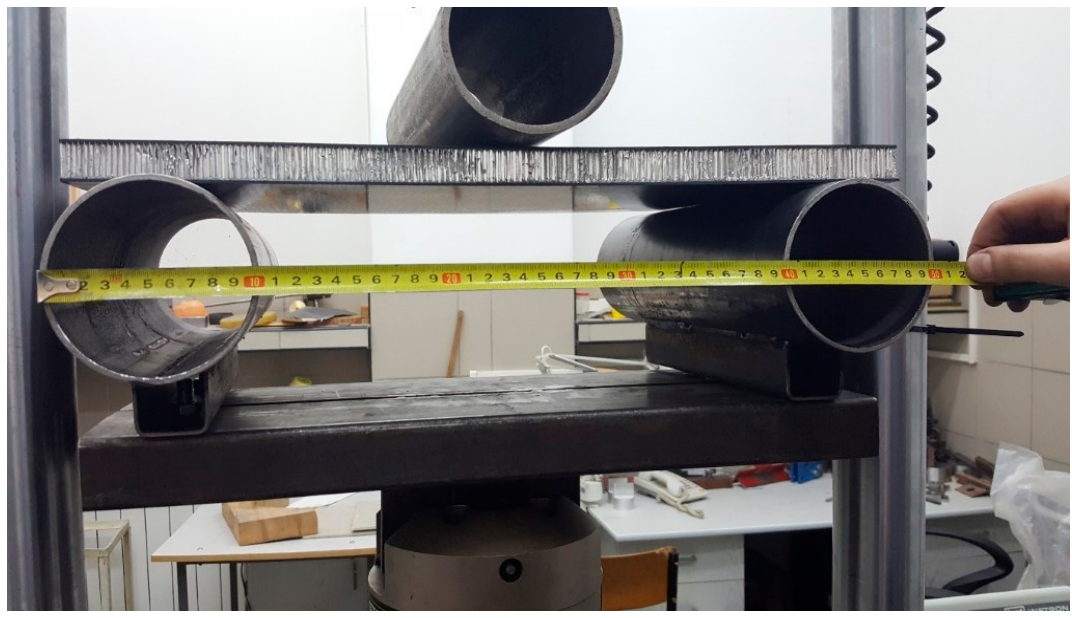
Figure 1. Three-point test setup .